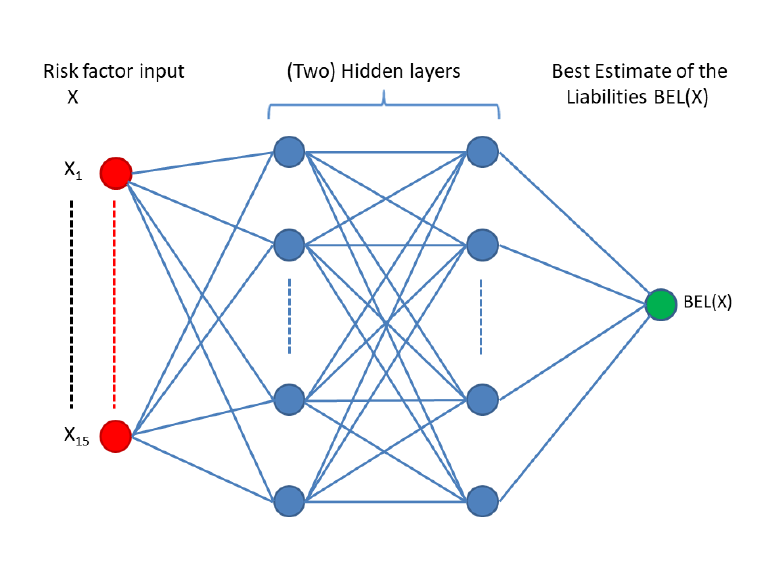
Figure 1. Schematic picture of a fully connected feed forward neural network with two hidden layers illustrating the mapping of risk factor input X to the best estimate of the liabilities BEL ( X )